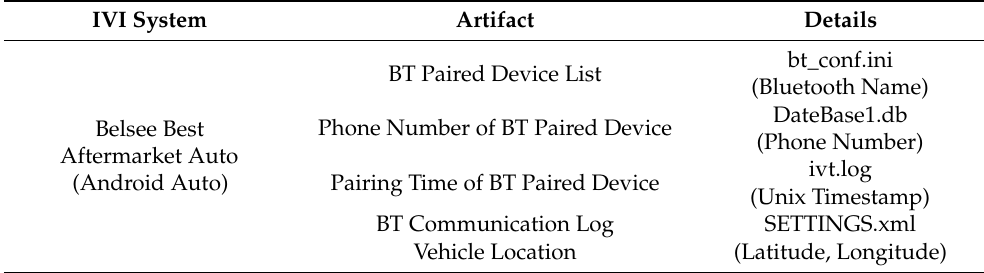
Figure 8. BT paired device list (bt_conf.ini) and phone number acquired from Belsee Best Aftermarket Auto (DateBase1.db). Table 8. List of Artifacts in IVI System Internal Storage.